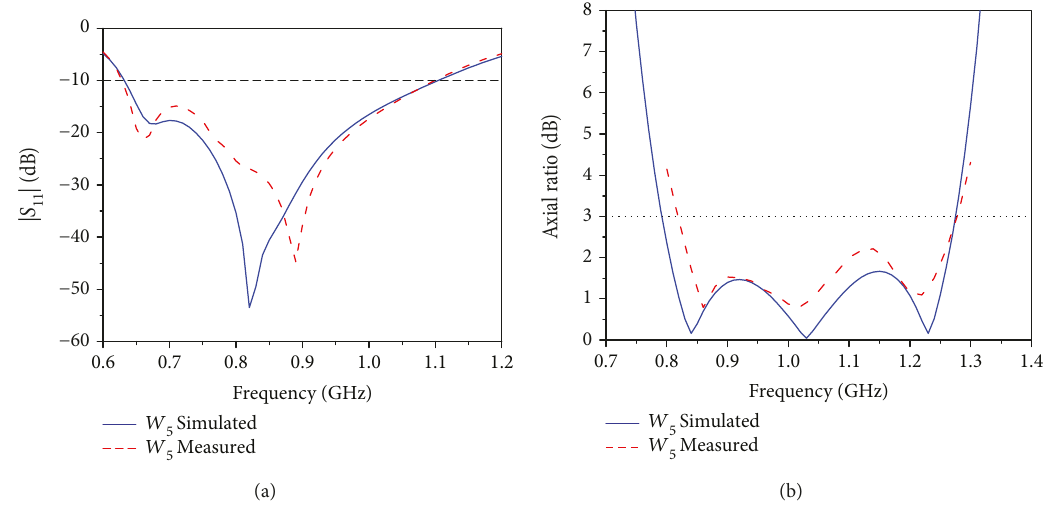
Figure 9: Measured and simulated (a) S